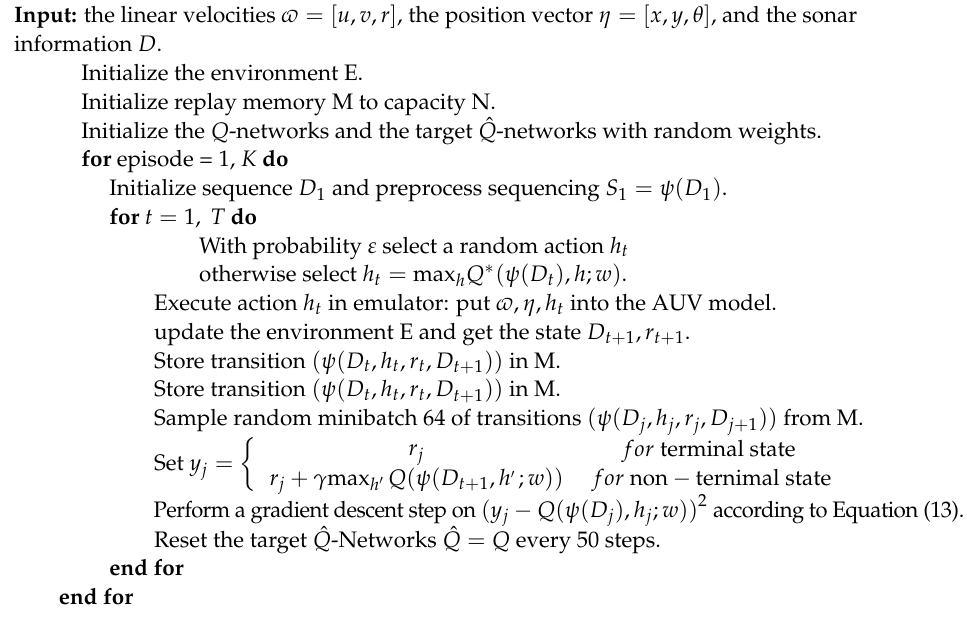
Figure 5. Using LSTM to implement the Q-network in Figure 4. The pseudo-code of the algorithm is as follows: Algorithm DQN-LSTM algorithm with experience replay for the